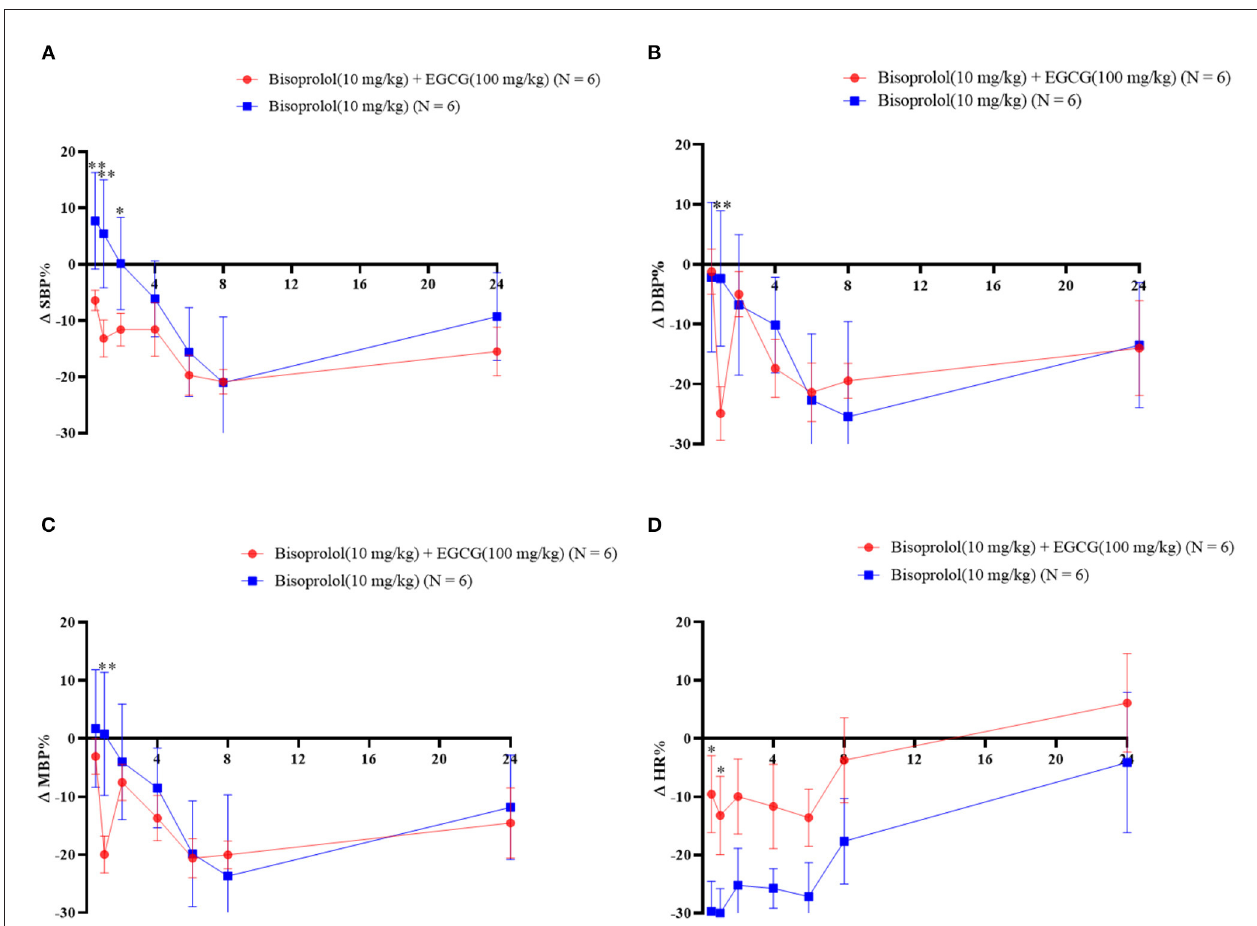
FIGURE 4 | The blood pressure and heart rate changes as percentages over time after gavage administration of bisoprolol with or without EGCG. * P < 0.05, ** P < 0.01. (A) Percentage change of SBP; (B) Percentage change of DBP; (C) Percentage change of mean BP; (D) Percentage change of heart rate.